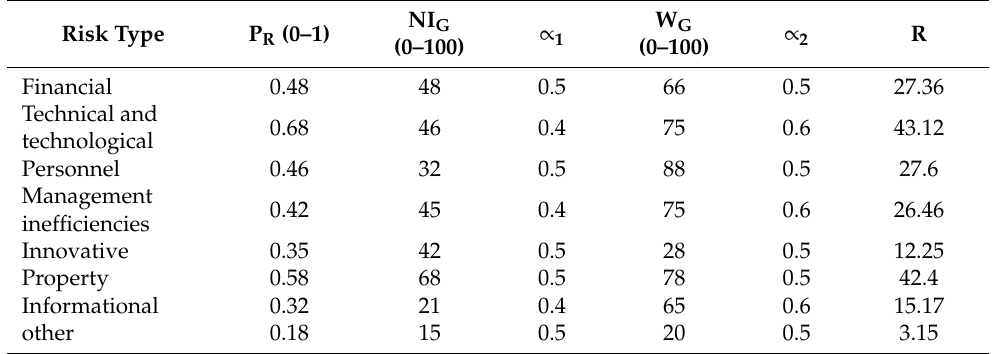
Table 5. The results of an expert assessment of the internal risks of enterprises of the “Valley of Mechanical Engineering” cluster, 2022 year (forecast).